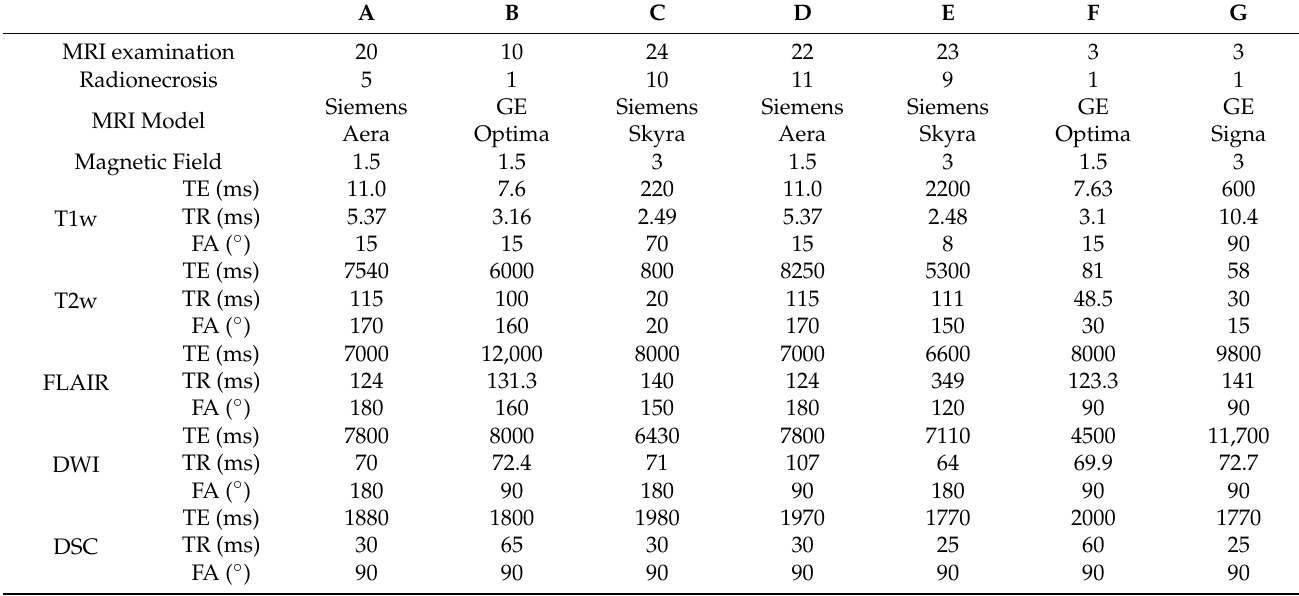
Table 2. Characteristics of each MRI protocol.